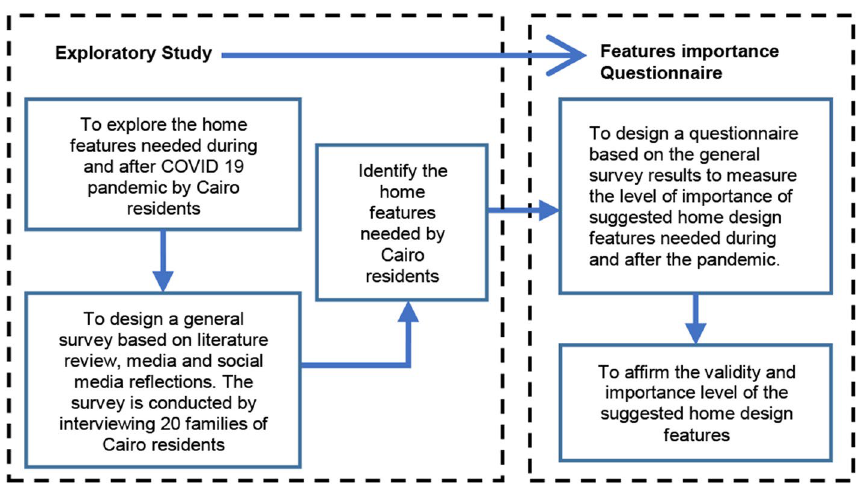
Fig. 1 Research methodology diagram. Ref: